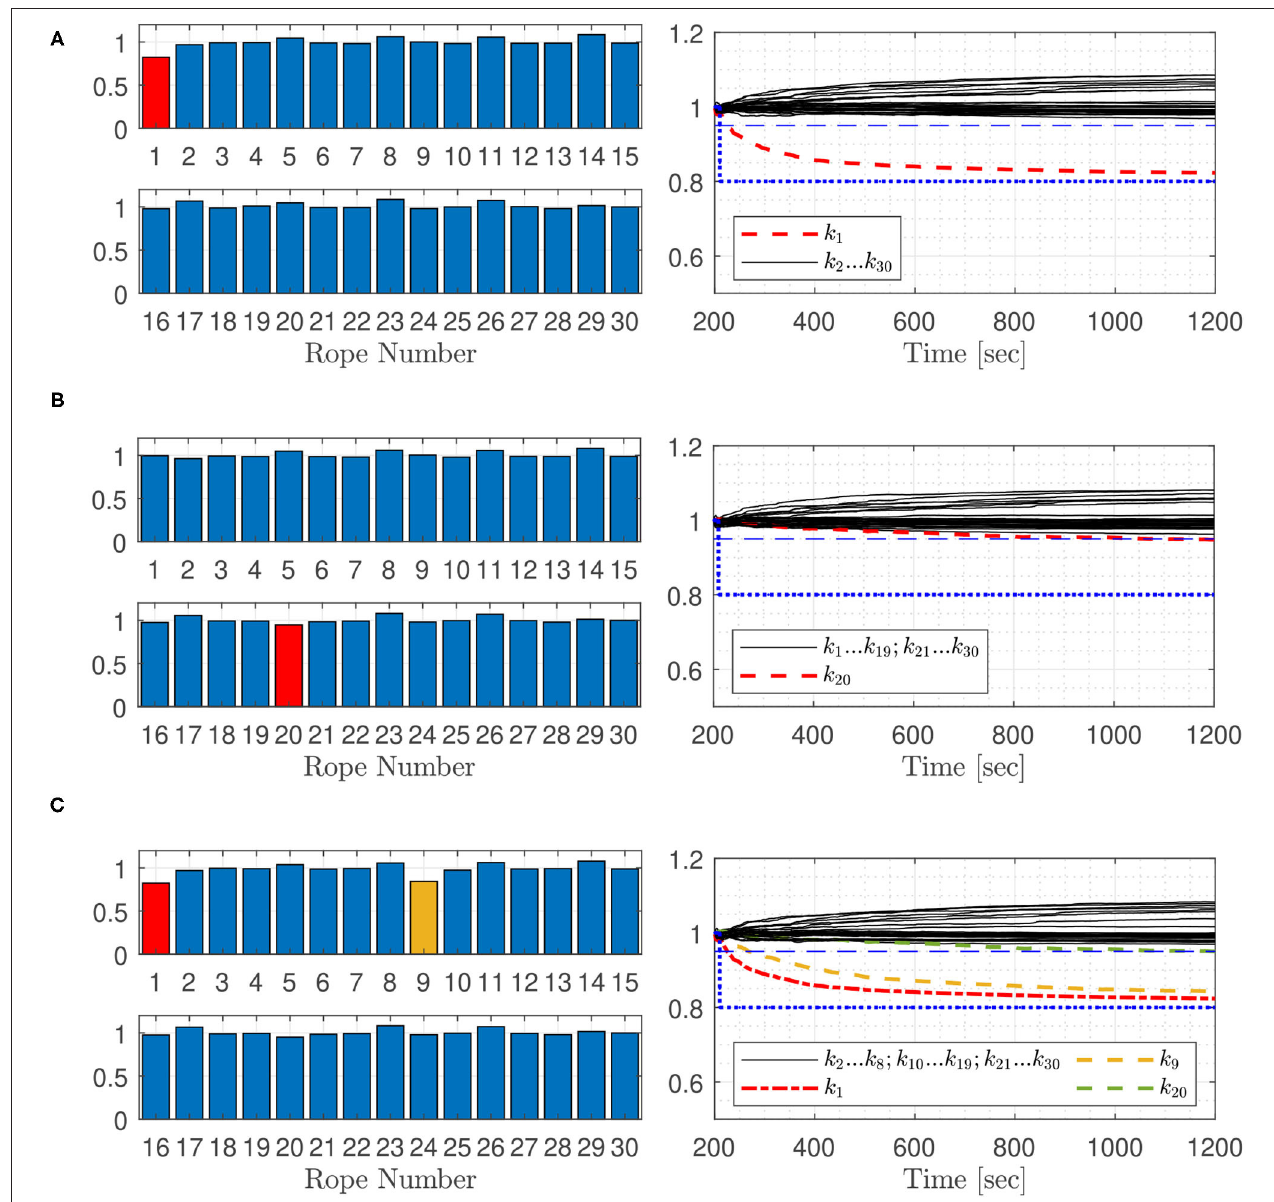
FIGURE 9 | Normalized estimated rope stiffness test cases 3A (A) , 3B (B) , and 3C (C)